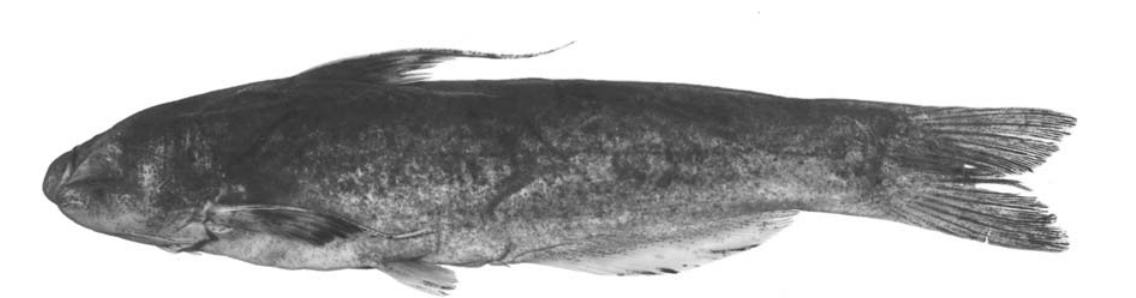
Fig. 20. Cetopsis fimbriata , new species, holotype, mature male, USNM 305348, 83 mm SL; Colombia, Choco, Creek of upper río Nercua, large tributary of río Truando (approximately 7°01’N,